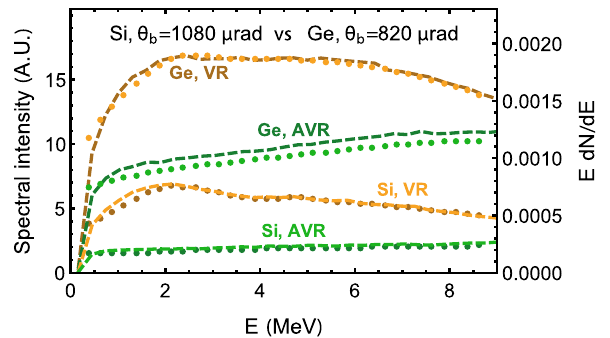
Fig. 4 Experimental (lines) and simulated (points) radiation spectral intensities for volume reflection ( − θ b / 2 ) and anti volume reflection orientation ( 0 < θ x < θ b ) for both Si and Ge bent crystals. Bending angles are 1080 µ rad (Si) and 820 µ rad (Ge)